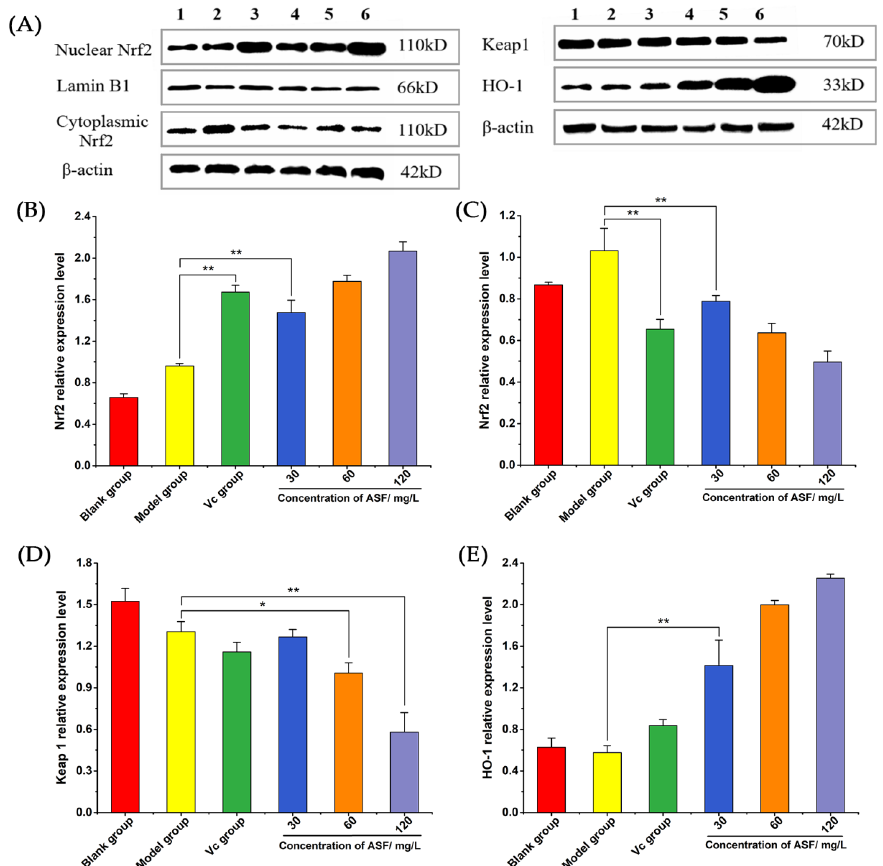
Figure 4. The expression level of Nrf2, Keap1, and HO-1 protein. ( A ) The bands of protein expres- sion: 1, blank group; 2, model group; 3, Vc group; 4, low-dose group (30 mg/L); 5, medium-dose group (60 mg/L); 6, high-dose group (120 mg/L). ( B ) The effect of A. senticosus flavonoids on the relative level of Nrf2 nucleoprotein. ( C ) The effect of A. senticosus flavonoids on the relative level of Nrf2 cytoplasmic protein. ( D ) The influence of A. senticosus flavonoids on the relative expression of Keap1 protein. ( E ) The effect of A. senticosus flavonoids on the relative expression of HO-1 protein. Note: For the comparison between the two groups, * indicates significant difference at p < 0.05. ** indicates extremely significant difference at p < 0.01.